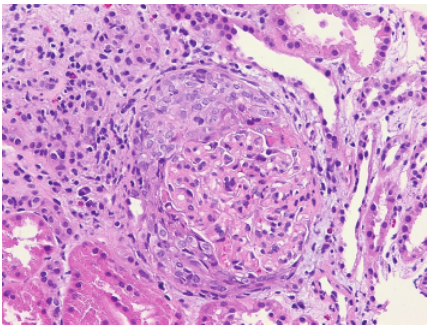
Figure 3: Case 3. Glomeruli with cellular crescent and segmental necrosis. Hematoxylin & Eosin, 200x